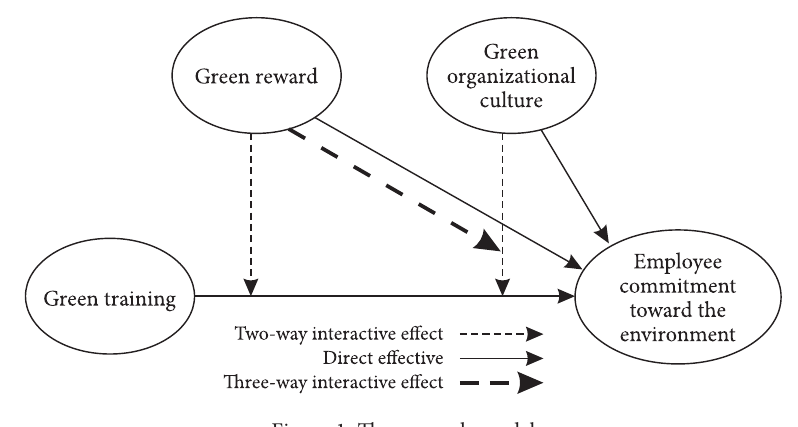
Figure 1. The research